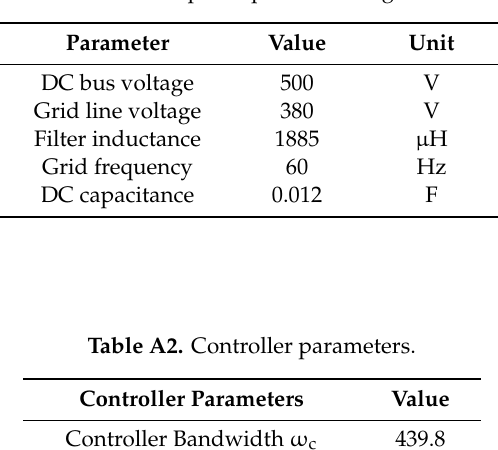
Table A1. Parameters of three-phase photovoltaic grid-connected inverter.